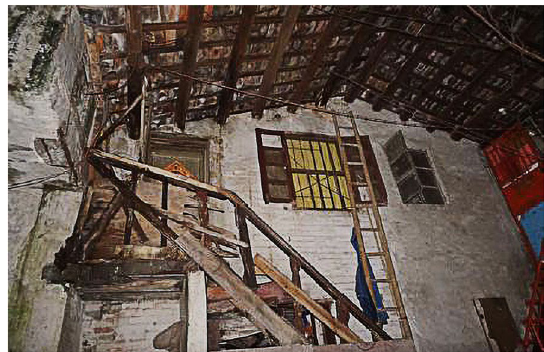
Fig. 3 The damaged original stairs at the House of Li. (Source: An-Design